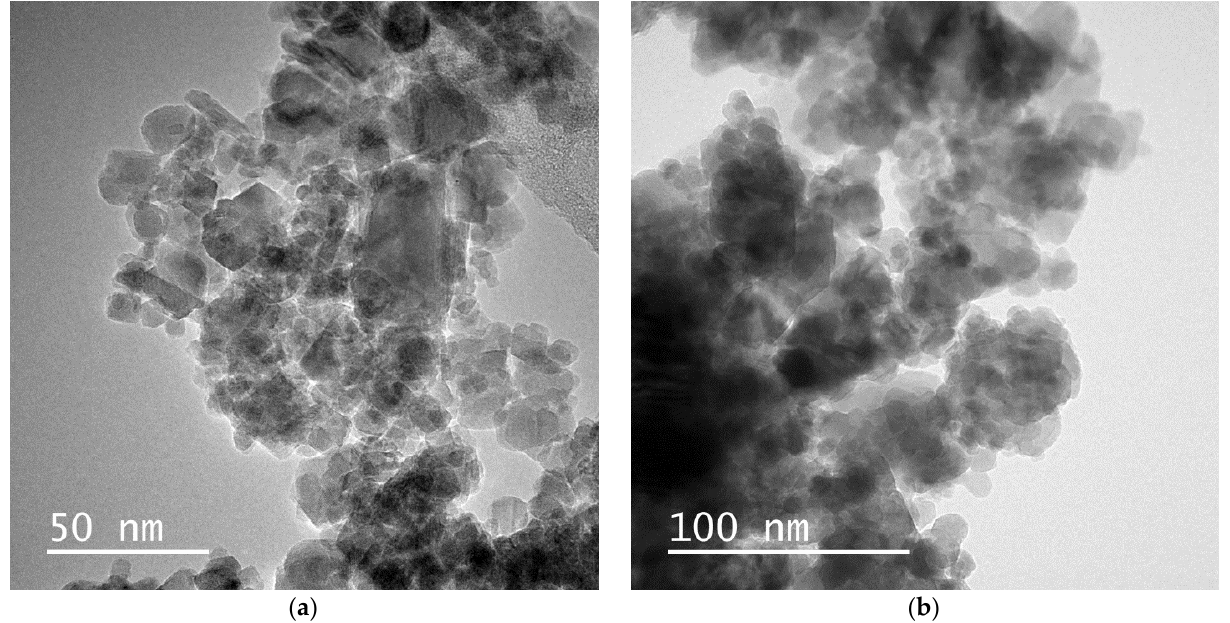
Figure 3. TEM micrographs of ( a ) uncoated and ( b ) coated (Fe 0.97 ,Ti 0.03 ) 3 O 4